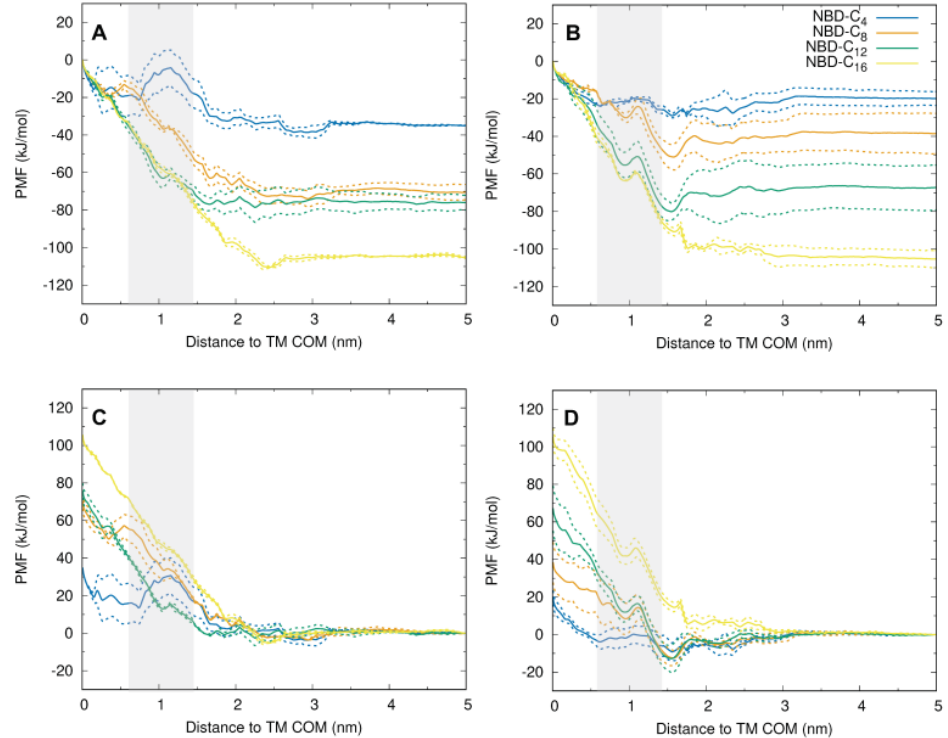
Figure 6. PMF profiles for the transfer of NBD–Cn from the complex asymmetric ( A , C ) or from the POPC ( B , D ) lipid bilayers to membrane embedded P–gp. In plots ( A , B ), the PMF energy reference is defined at 0 nm from the TM COM of P–gp, while in plots ( C , D ), the reference is defined in the bulk membrane (5 nm). The gray shading denotes the gate region of P–gp. Error estimates are shown as dotted lines.